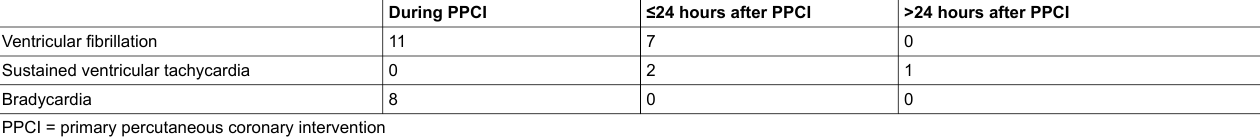
Table 3: Characteristics of patients with life-threatening arrhythmias who died within the first 30 days after hospital admission. Gender Age (years) STEMI localisation IRA Male 68 Anterior LAD 3 Peri-procedural VF During PPCI Cardiogenic shock Female 70 Inferior LCX 0 Peri-procedural asystole During PPCI PEA Female 84 PEA